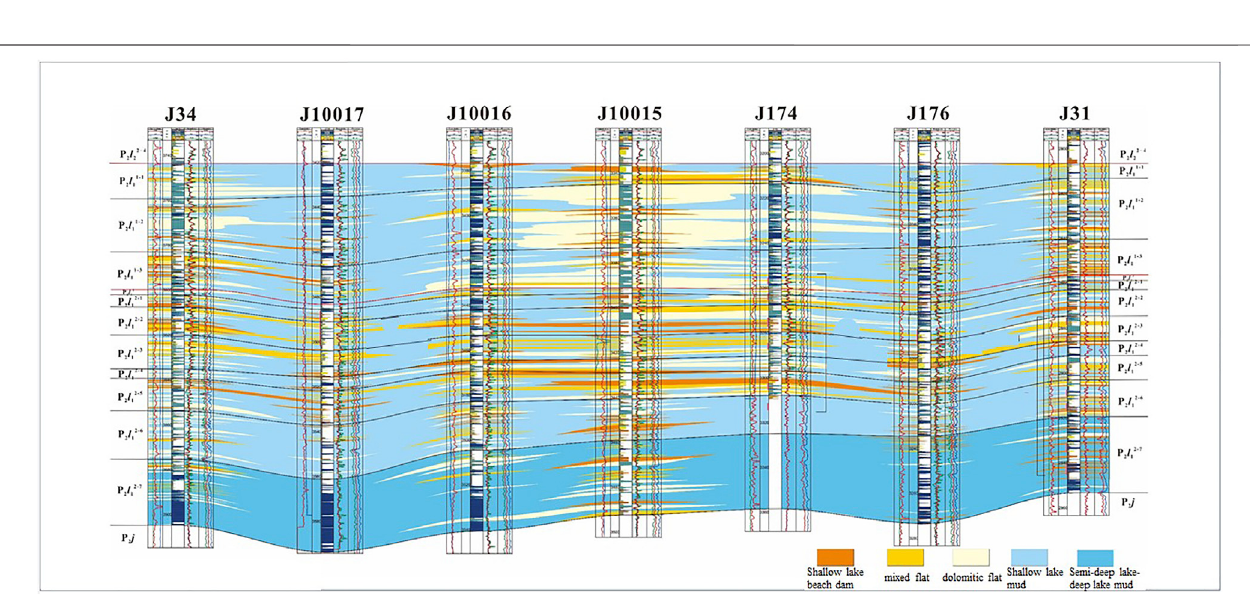
Frontiers in Earth Science |